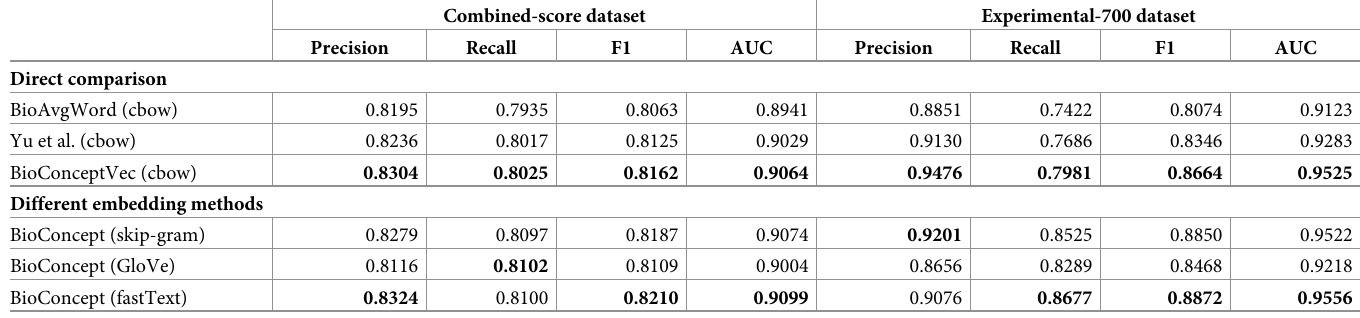
Table 6. Classification results of PPI predictions on the STRING database. Combined-scores: PPIs that have combined scores are considered positive cases. Experi- mental-700: PPIs that have experimental scores over 700 are considered positive cases. Direct comparison: the results of embeddings using the same method (cbow)